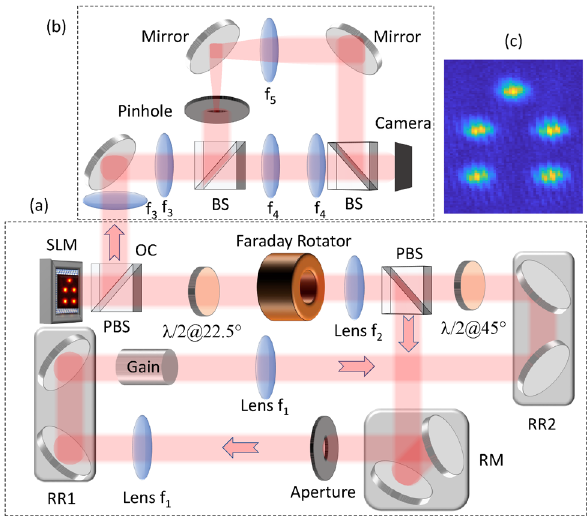
Figure 2: Schematic illustration of the experimental setup used to support a laser oscillator network and to measure its state. (a) Folded ring degenerate cavity laser supporting the oscillator network. (b) Interferometer for laser network intensity and phase measurement.(c)Thedetectedinterferencefringesforahouselaser network with equal amplitudes. Abbreviations: SLM – spatial light modulator, OC – outputcoupler, PBS – polarizing beamsplitter, RR1 and RR2 – retro reflecting mirrors, RR2 – retro reflecting mirrors, λ / 2 – half wave plate, BS – beam splitter, RM – re fl ector